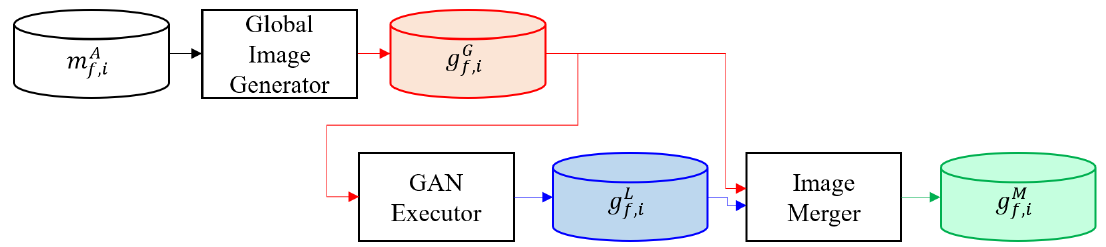
Figure 4. Global image and local image merging process.